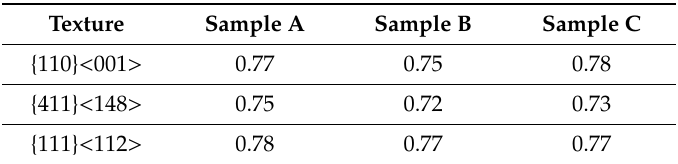
Table 3. Texture composition of the decarburized samples, area ratio / %.